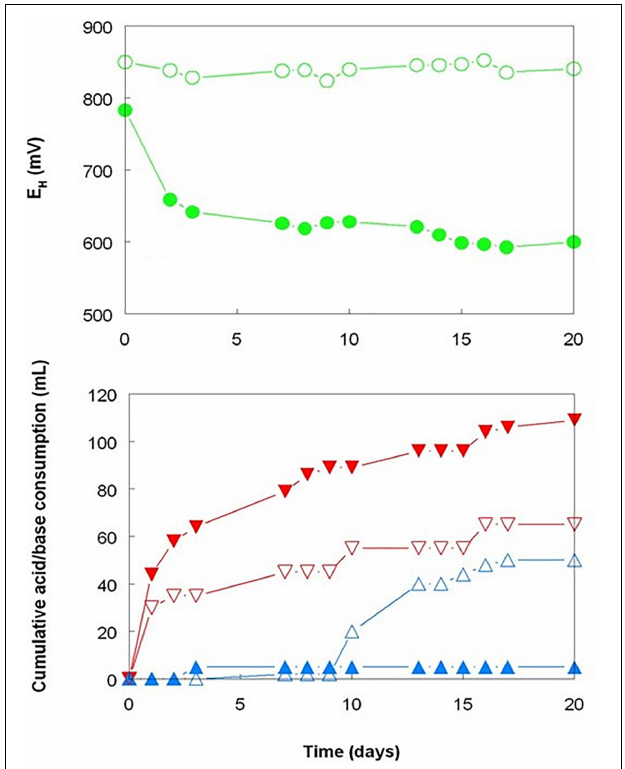
FIGURE 1 | Comparison of redox potentials and acid/base consumption during bioleaching of Shevchenko limonite by a mesophilic consortium of iron-oxidizing/reducing Acidithiobacillus spp. maintained at pH 1.8 and 35 ◦ C under aerobic (hollow symbols) or anaerobic (filled symbols) conditions. Key: (o, ) E H ; ( (cid:72) , ∇ ) acid; and ( (cid:78) , (cid:49) ) (cid:32)